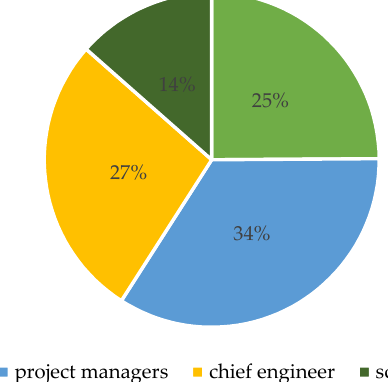
Figure 3. Occupational distribution map of 237 respondents.